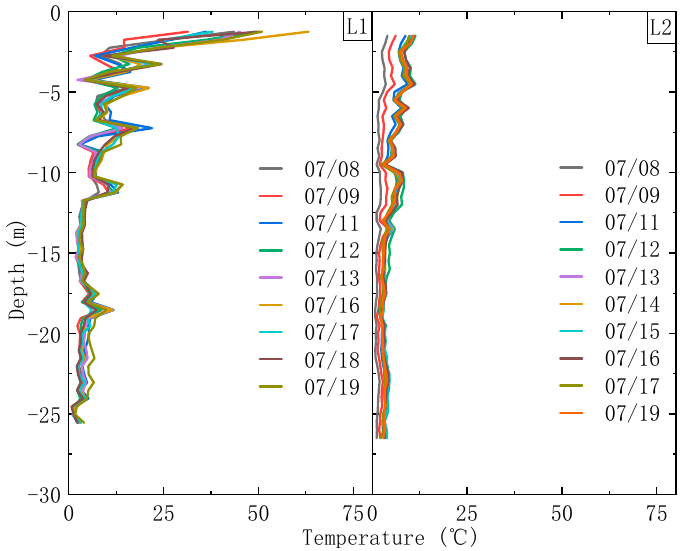
Figure 12. Temperature profile along the joint at L1 and L2 after active heating.